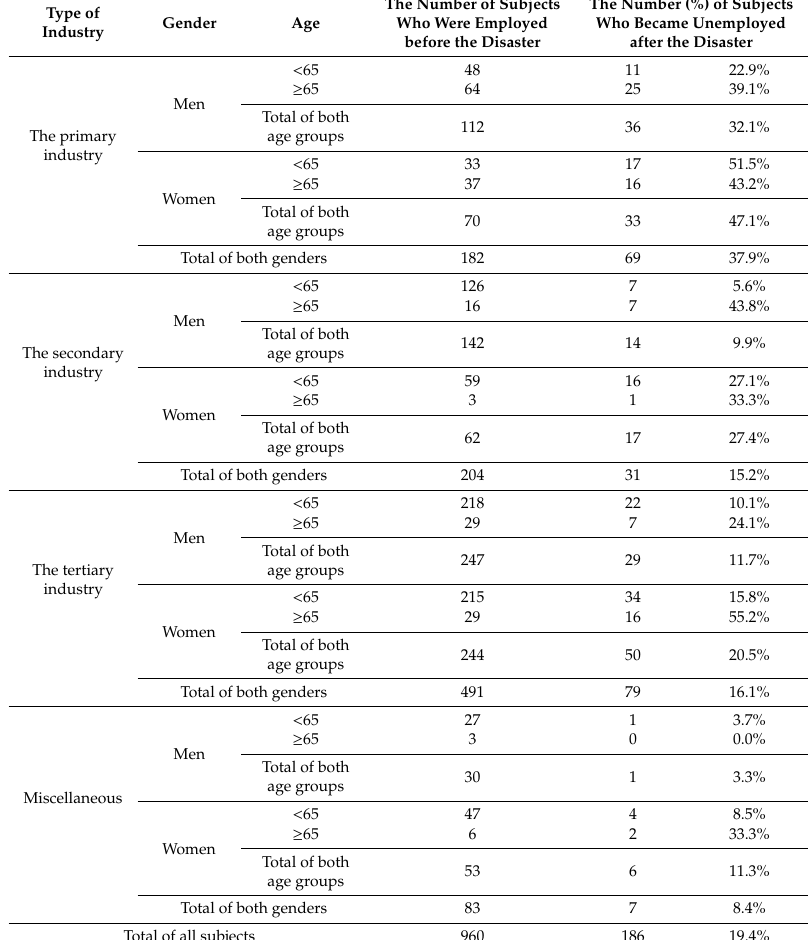
Table 4. The number (%) of subjects who became unemployed after the Great East Japan Earthquake in subjects who were employed in each type of industry before the